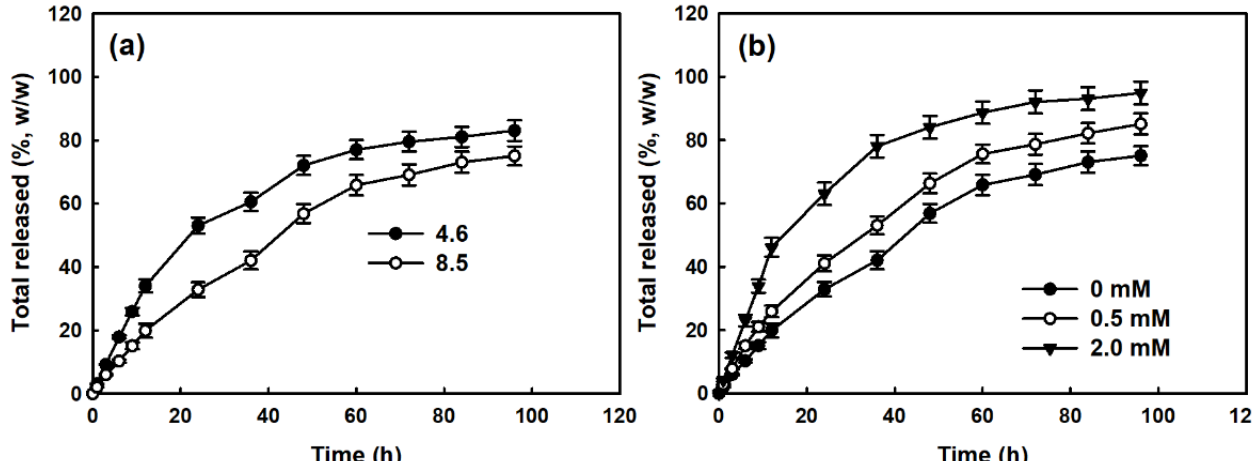
Figure 7. The effect of ROS on the Ce6 release from nanophotosensitizers. ( a ) The effect of Ce6 contents on the nanophotosensitizers. ( b ) The effect of H 2 O 2 concentration on the Ce6 release from nanophotosensitizers. The results are the average ± standard deviation (s.d.) from three separate experiments.